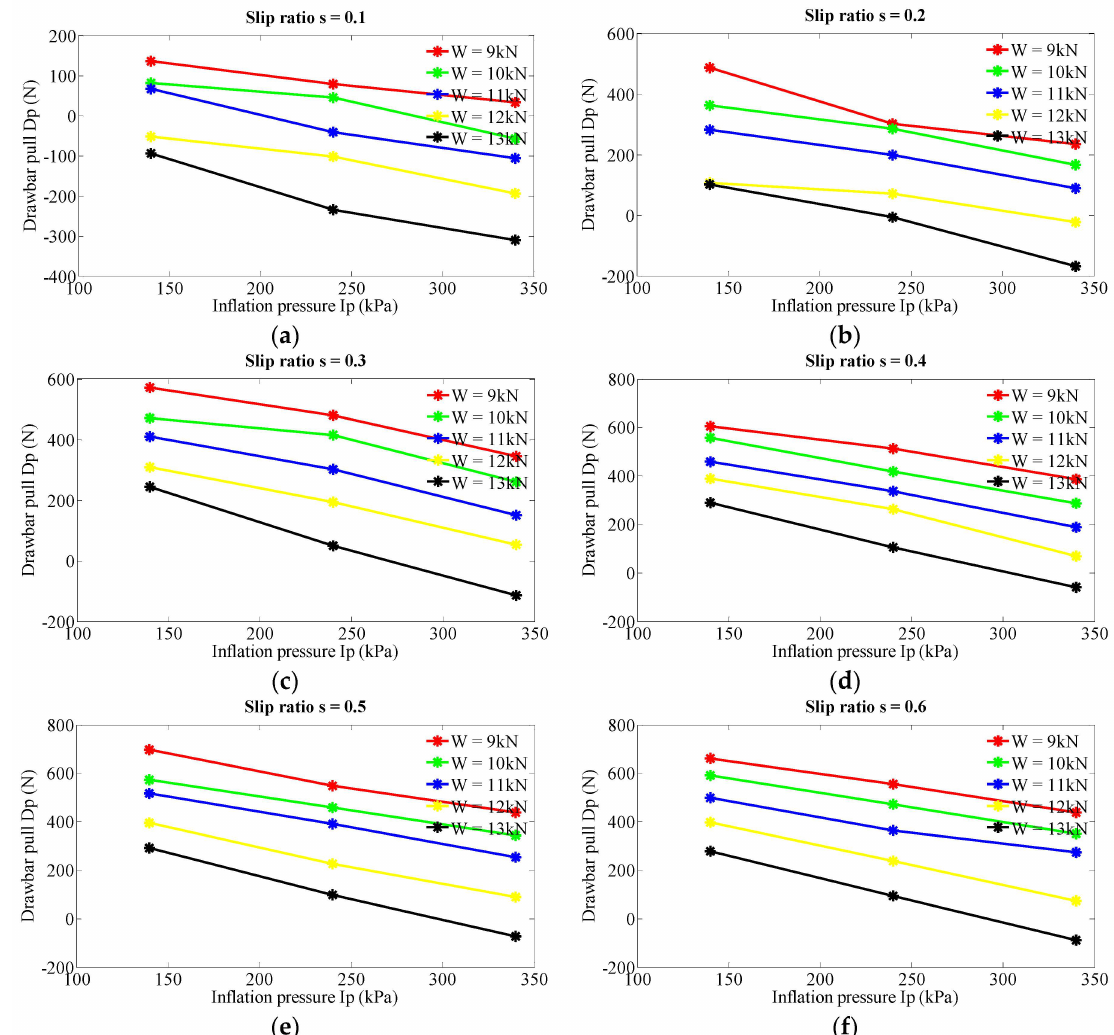
Figure 5. Effect of inflation pressure on drawbar pull at various levels of vertical load and slip ratio. ( a ) Slip ratio s = 0.1; ( b ) Slip ratio s = 0.2; ( c ) Slip ratio s = 0.3; ( d ) Slip ratio s = 0.4; ( e ) Slip ratio s = 0.5; ( f ) Slip ratio s =